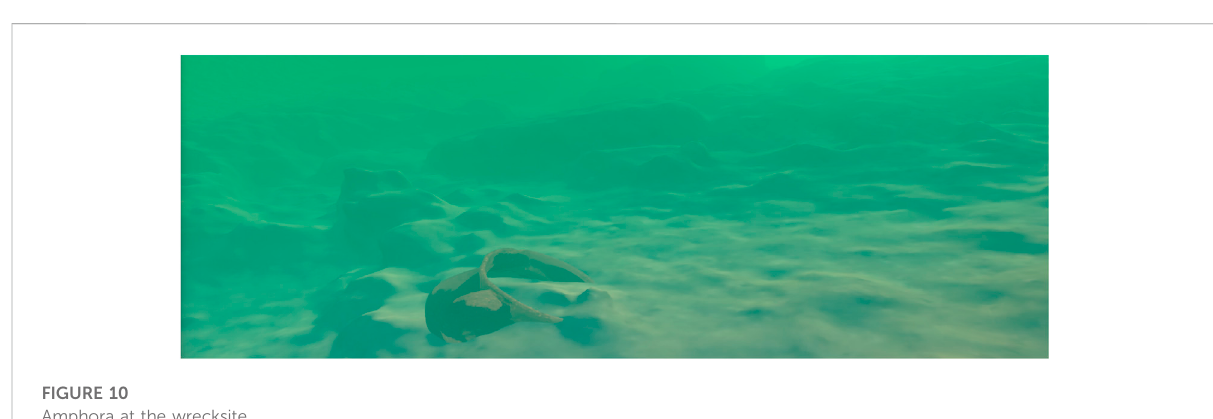
FIGURE 10 Amphora at the